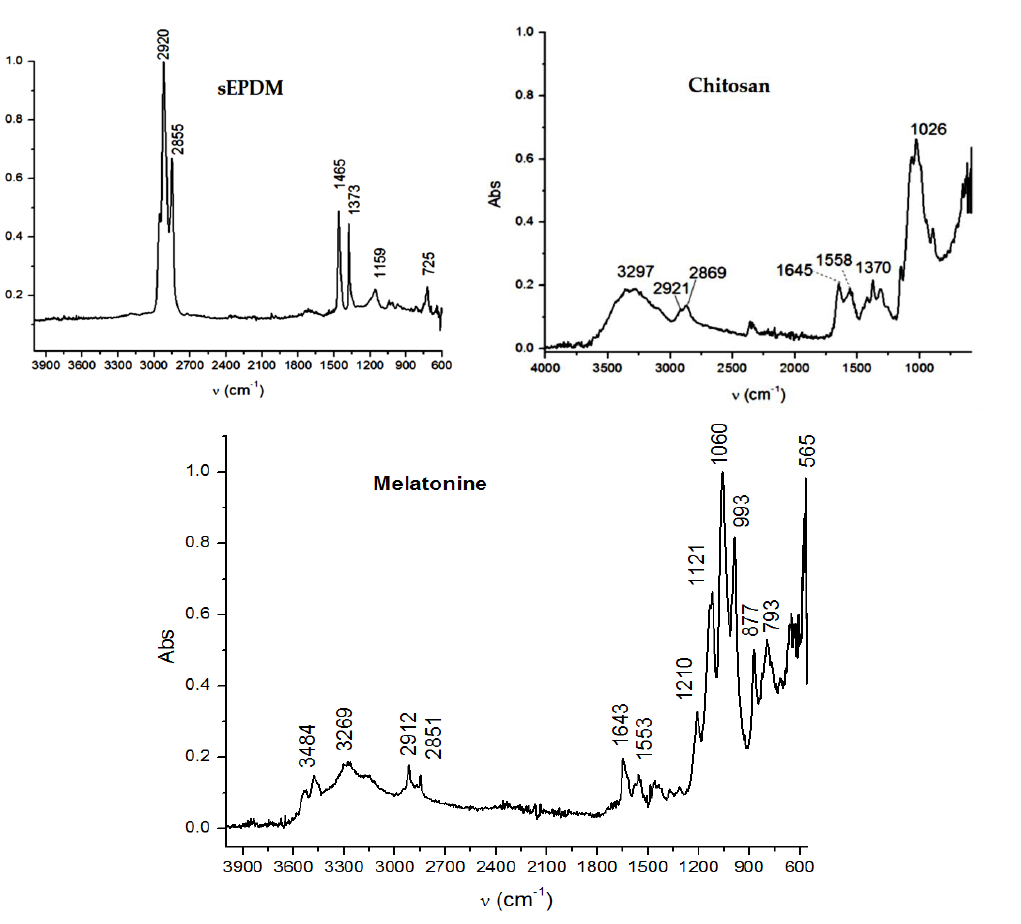
Figure 7. Fourier transform infrared spectra for: sulfonated ethylene-propylene-diene terpolymer (sEPDM); chitosan (Chi), and melatonin (Mel).